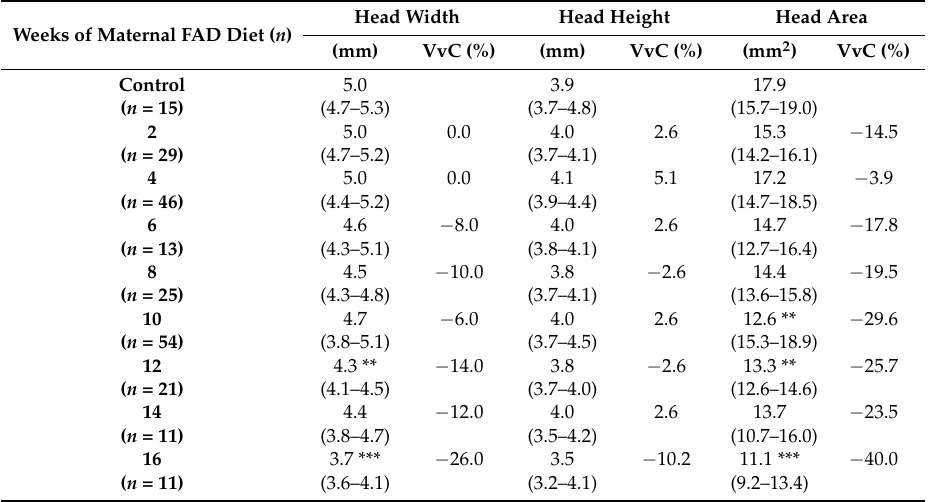
Table 4. Effects of folate deficiency on head